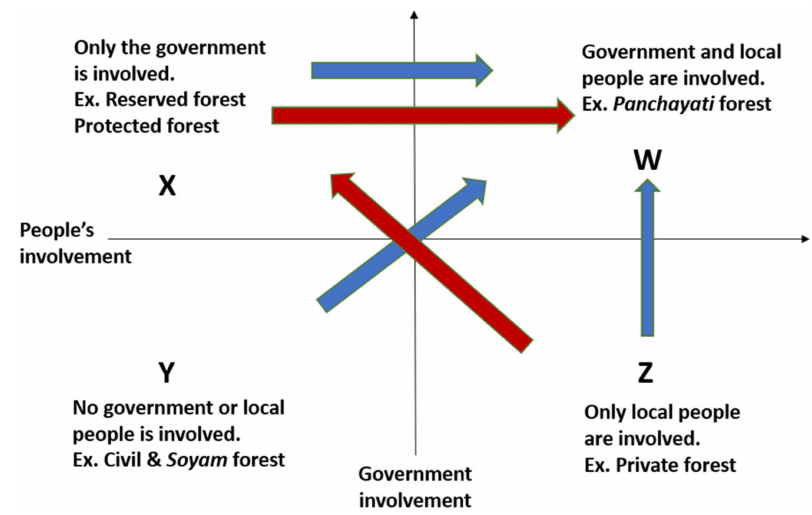
Figure 6. Formation process of panchayat forest land. Source: based on